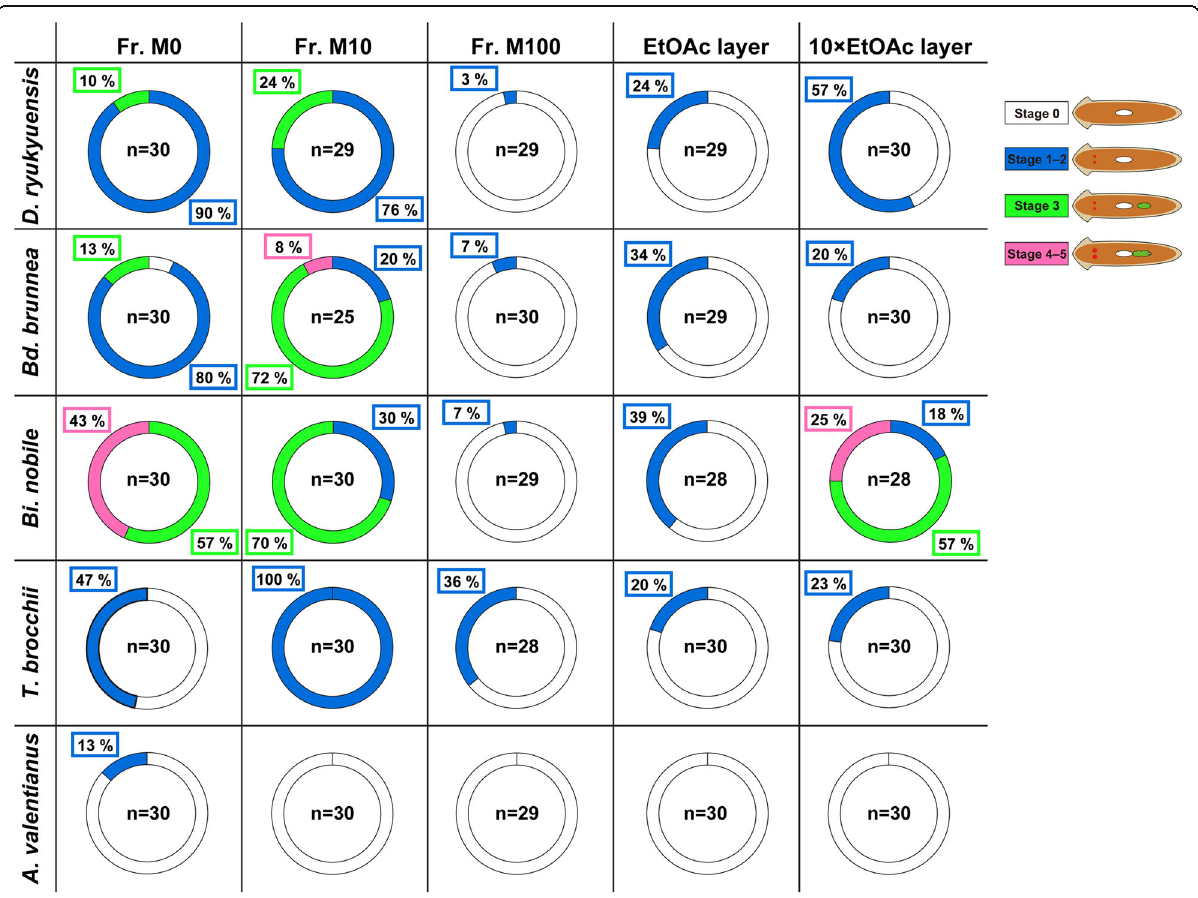
Fig. 4 Comparison of sex-inducing activity toward asexual worms of D. ryukyuensis. For the assay of the three fractions from the cytosolic fraction and EtOAc layer, test worms at the three stages of sexual induction identified by external observation were expressed as a doughnut chart. The number of test worms after the bioassay is shown in the center of a doughnut chart. The illustrations of worms in the figure correspond to those in Fig. 3b. The percentage of worms at each of the three stages of sexual induction is shown in the box drawn by colored